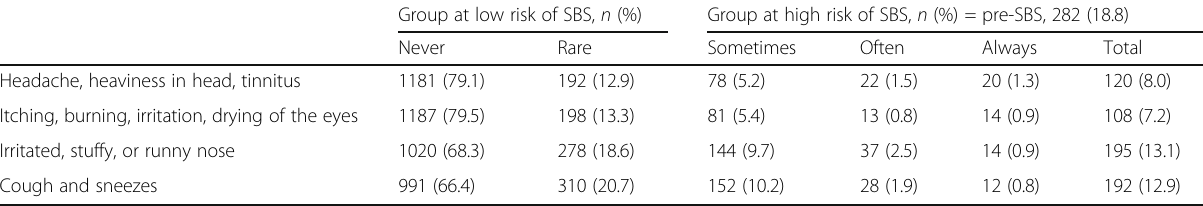
Table 2 Prevalence and characteristics of Pre-SBS